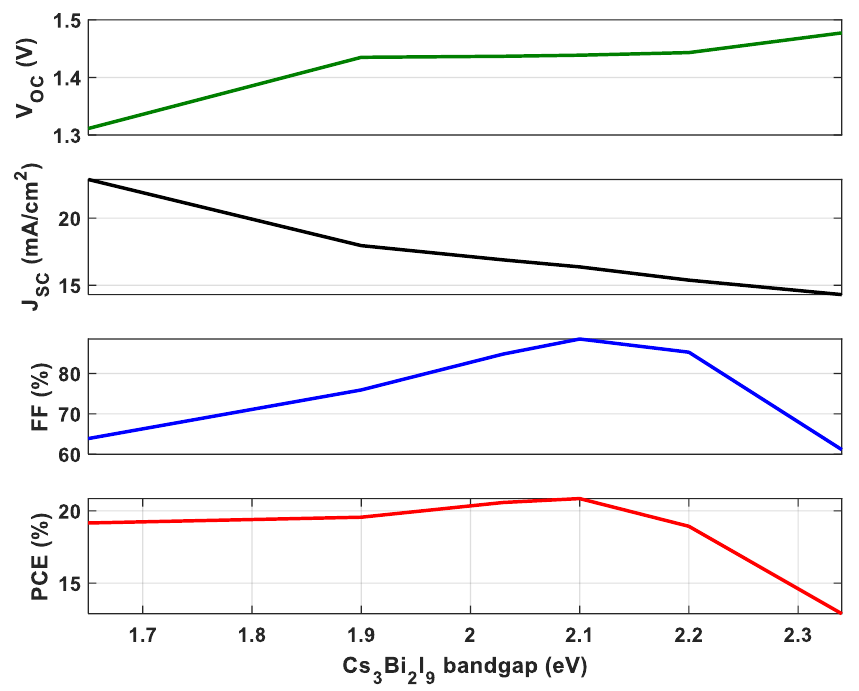
Figure 4. Effect of Cs 3 Bi 2 I 9 bandgap on the performance parameters.